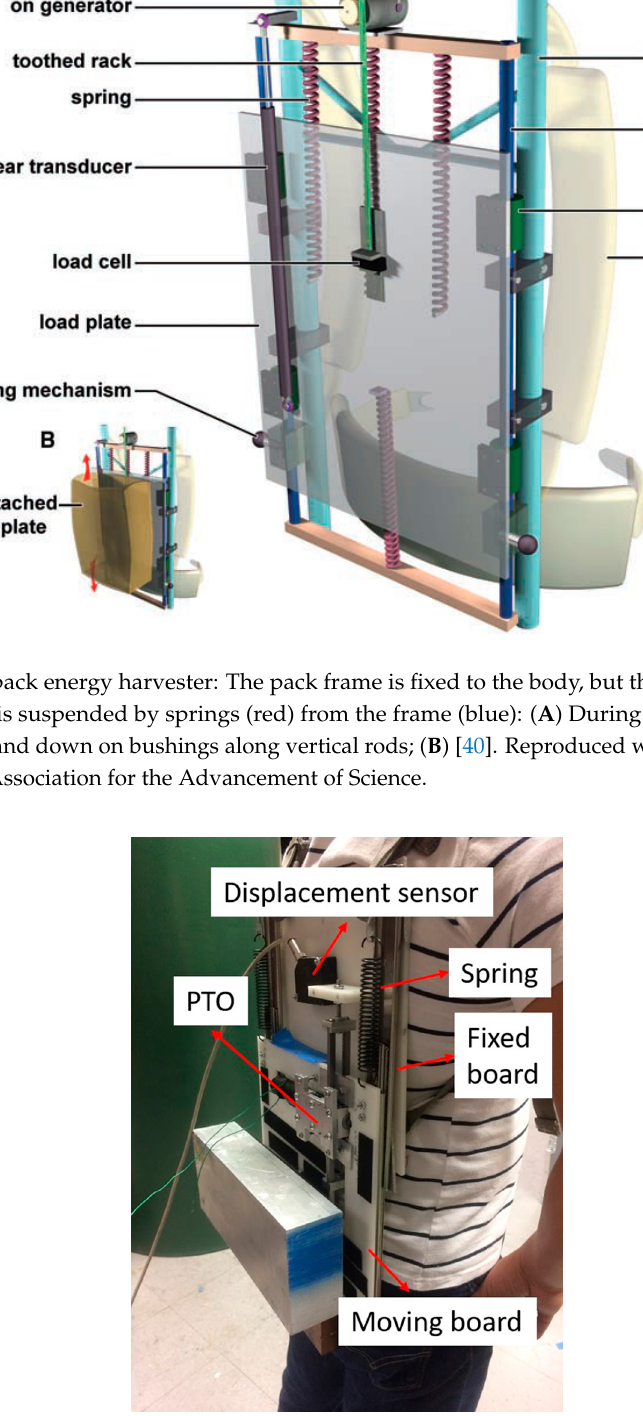
Figure 3. Backpack energy harvester using a mechanical motion rectifier (MMR) [1]. A power-take-off unit (PTO) consists of a MMR and a generator. The MMR uses a rack gear and a one-way bearing to convert bi-directional body movements to a unidirectional rotation of the generator. One end of the rack gear is fixed to the human body and the PTO moves up and down with the moving board supported by springs. Reproduced with permission from the Society of Photo Optical Instrumentation Engineers (SPIE).